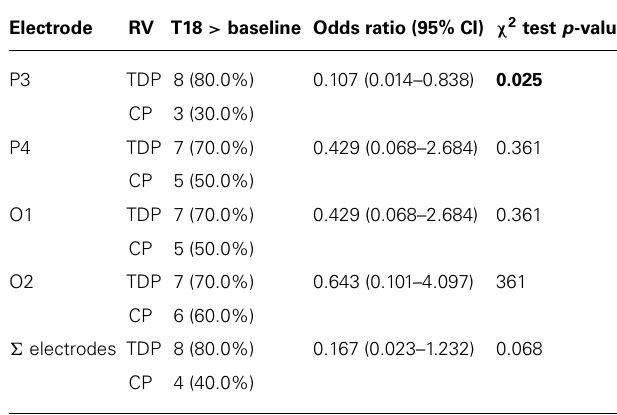
FIGURE 1 | Mean of the Mini-Mental State Examination (MMSE) score at baseline andT6,T12, andT18 follow-up in each of the two groups (RV-TDP, rivastigmine transdermal patch; RV-CP, rivastgmine capsules).